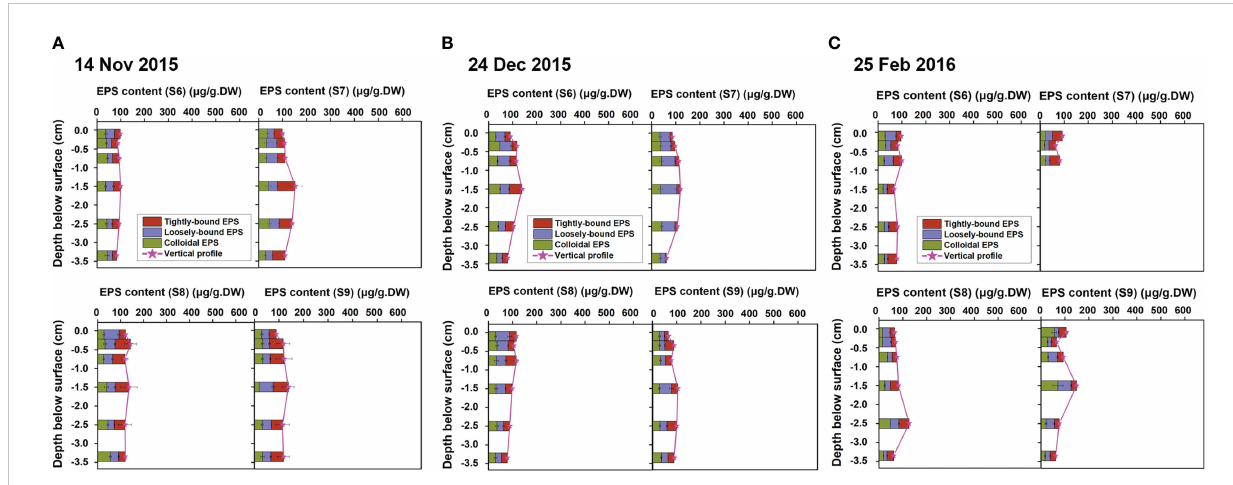
FIGURE 5 Vertical pro fi les of EPS (represented by strati fi ed EPS of tightly-bound EPS, loosely-bound EPS and colloidal EPS) in the sediment samples collected at S6~S9 in Autumn and Winter, in November 2015 (A) , December 2015 (B) and February 2016 (C) , note that data were missing for